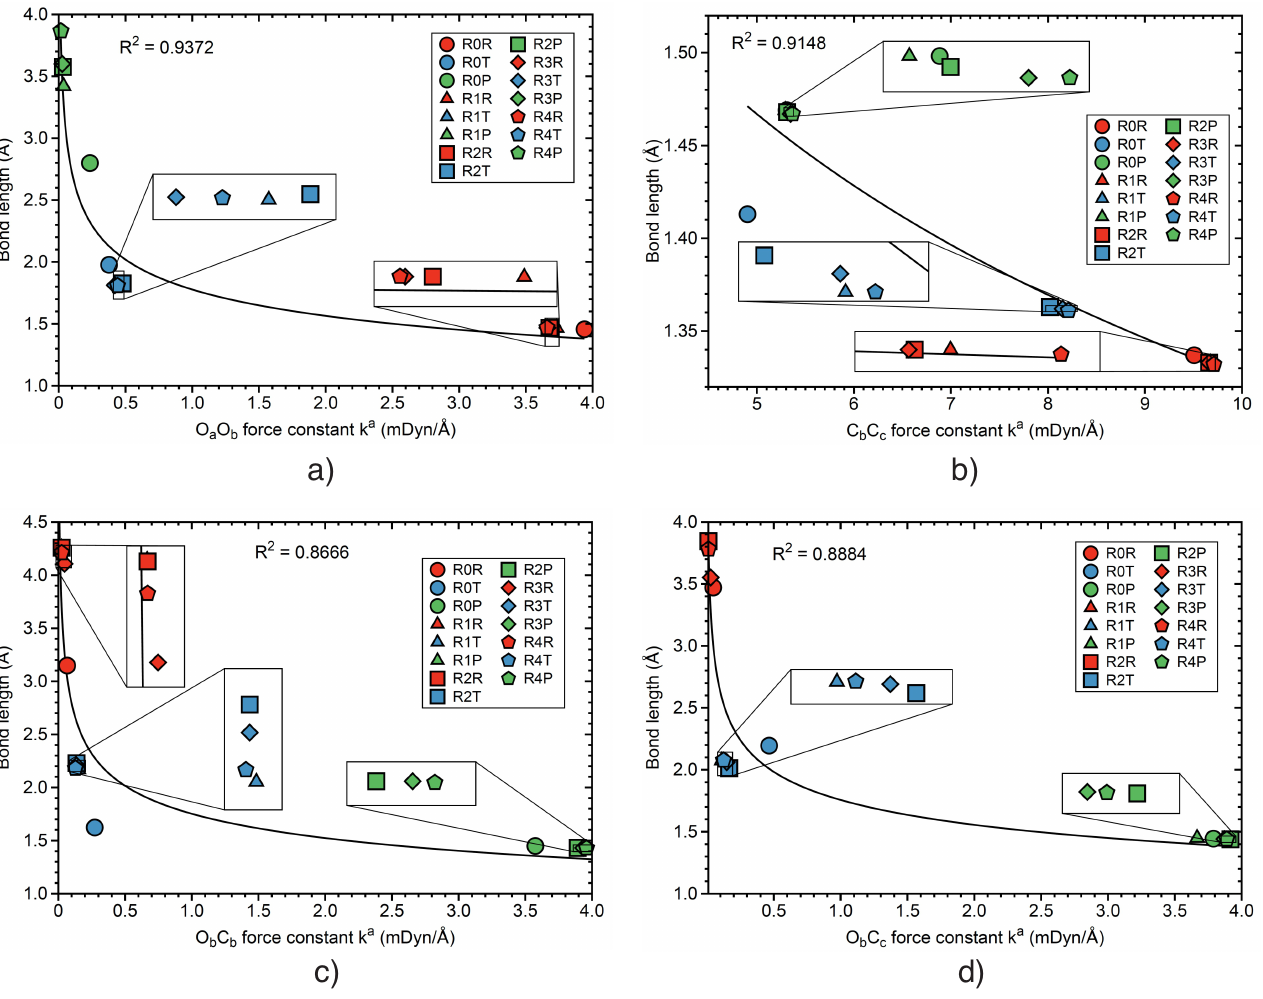
Figure 13. Correlation between bond lengths and local mode force constants. ( a ) OO bond, ( b ) CC bond, ( c ) O b C b bond and ( d ) O b C c bond. RnR, RnT and RnP indicate the reactant (red color), TS (blue color) and product (green color) for reactions Rn , with n=0, · · · 4. B3LYP/6-31G(d,p)/SDD(Ti) level of